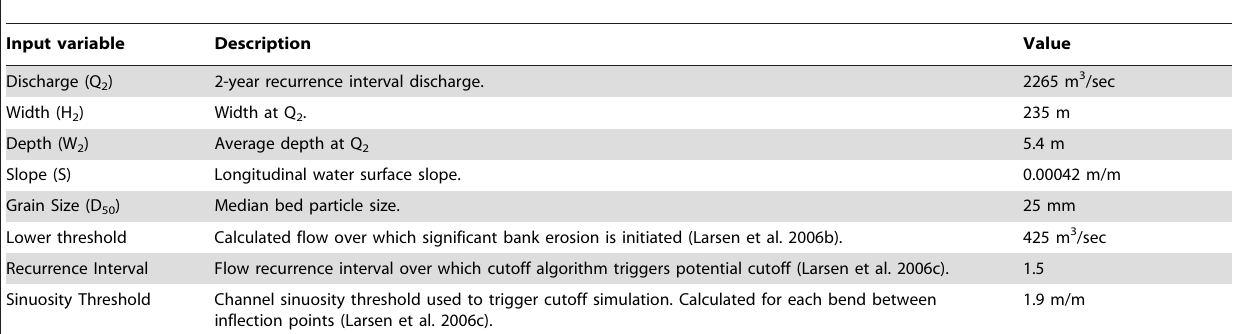
Table 2. Meander migration model – geomorphic and hydraulic variables.